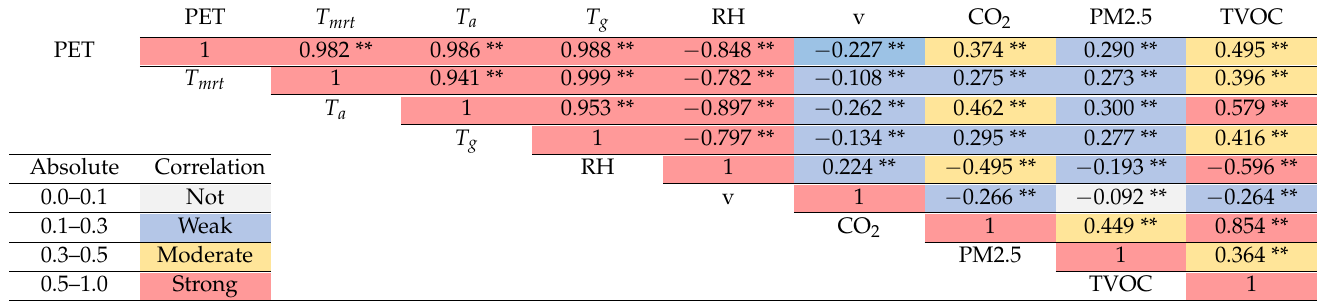
Table 6. Pearson correlation analysis of environmental parameters.